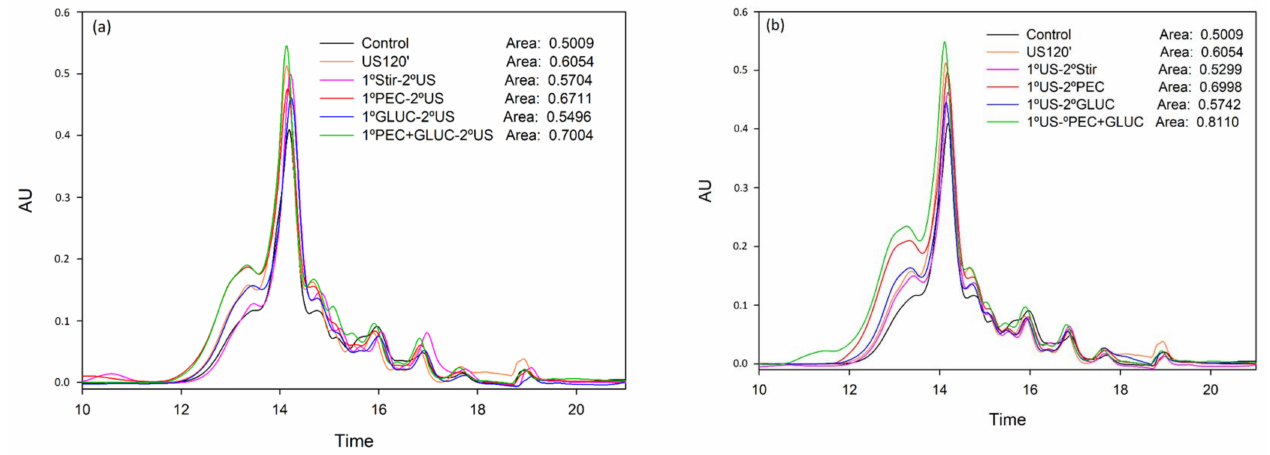
Figure 2. Mass distribution of the tannins released from lees analyzed by SEC in the elution time comprised between 12 and 20 min. ( a ) Comparison of tannins composition released when the enzyme treatments were added first and US treatment second. ( b ) Comparison of tannins composition released when the US treatment was used first and enzyme treatments were added second. This figure was made in SigmaPlot